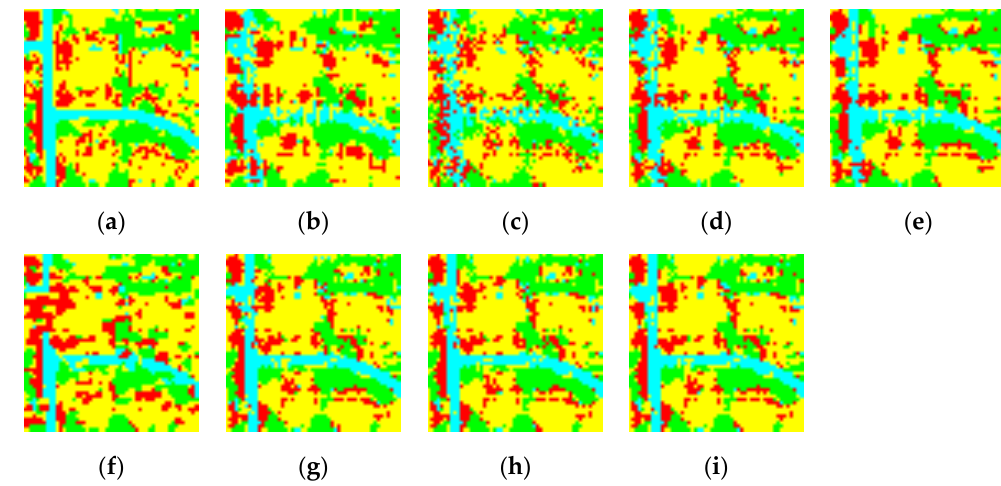
Figure 13. Zoomed areas of each sub-pixel mapping result: ( a ) Zoom of the original classification result of the 2004 QuickBird Image; ( b ) Zoom of the PSSM result; ( c ) Zoom of the GASM result; ( d ) Zoom of the DESM result; ( e ) Zoom of the CSSM result; ( f ) Zoom of the SSMPS result; ( g ) Zoom of the SSMGA result; ( h ) Zoom of the SSMDE result; and ( i ) Zoom of the SSMCS result.